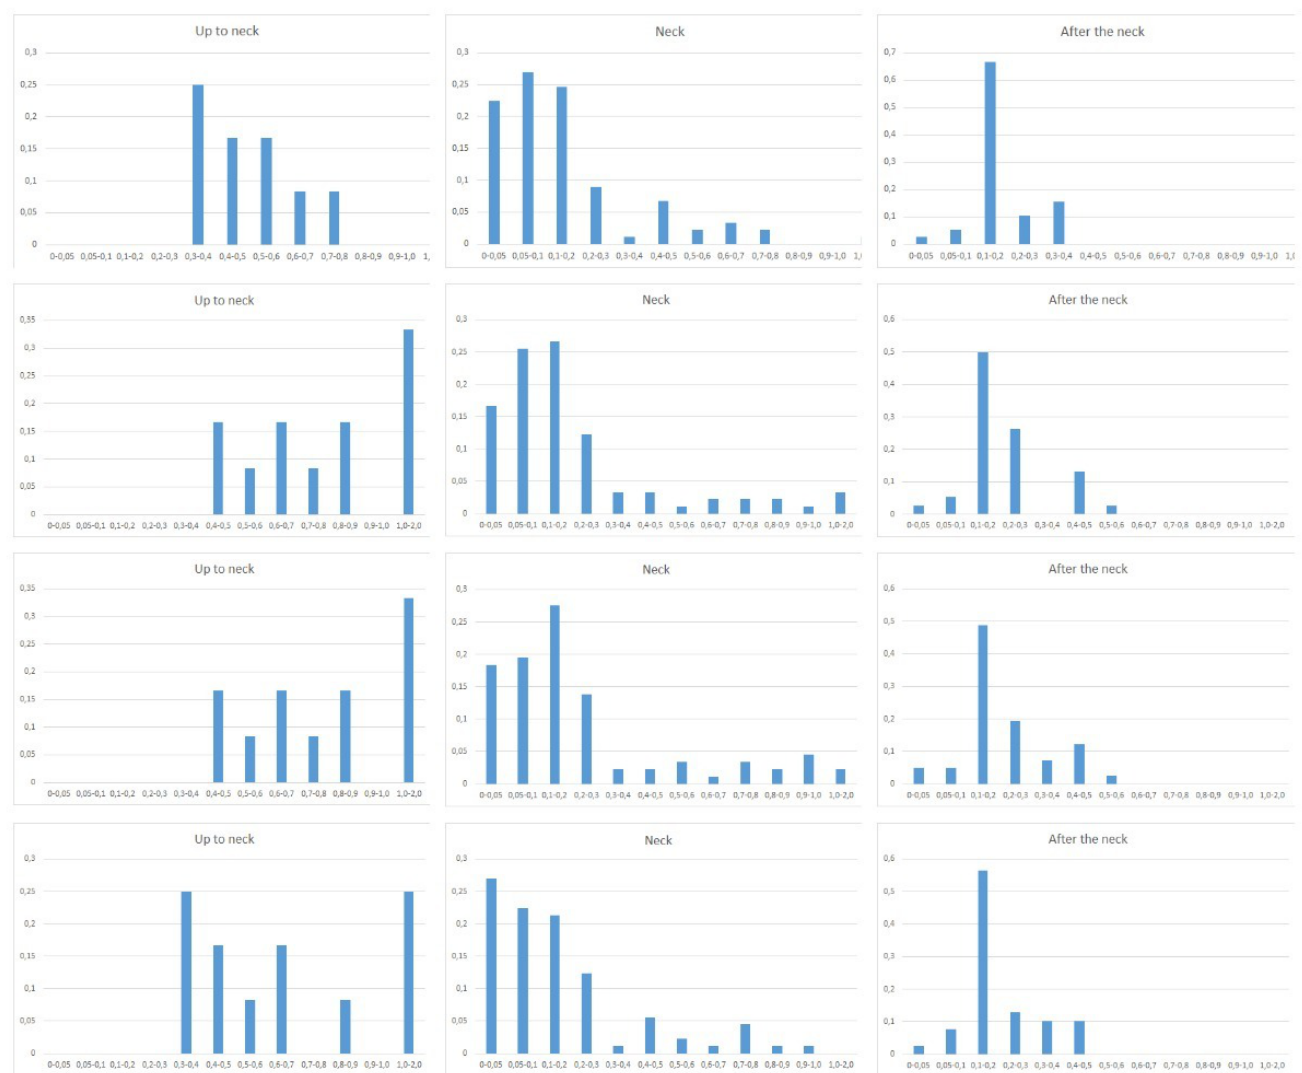
Figure A1. Histograms of ∆ WSS distribution over the stent surface of Patient